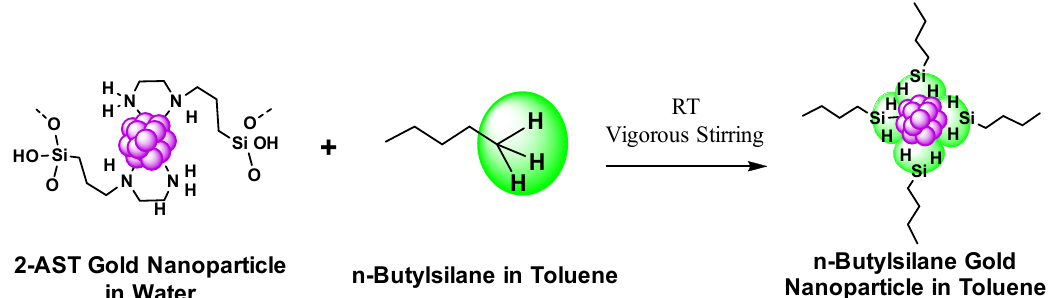
Scheme 1. Representation of the phase transfer of 2-AST gold nanoparticles through a ligand exchange with n-butylsilane.